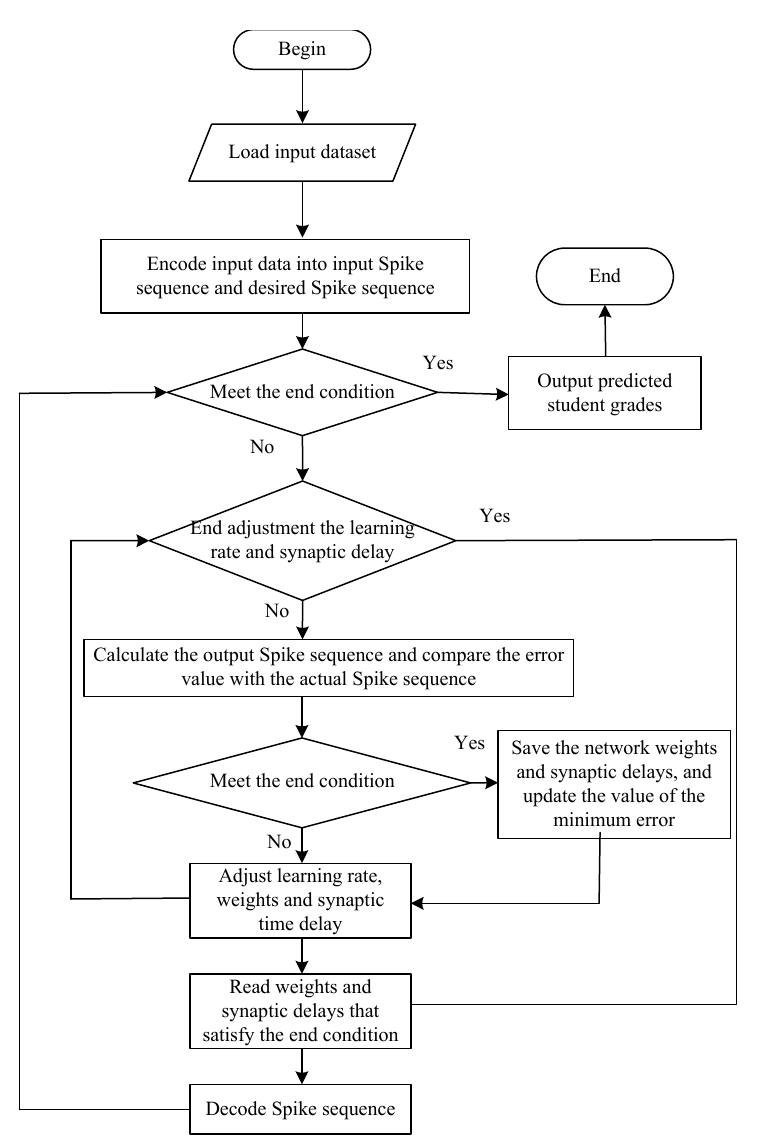
Figure 3. The architecture of student achievement prediction model. Gradient descent learning algorithms should budget based on the neuron’s internal state variables. This paper uses spike response mode (SRM) 0, which is a simplified model of the SRM model [35], and its specific internal state variables are shown in Equation (3).